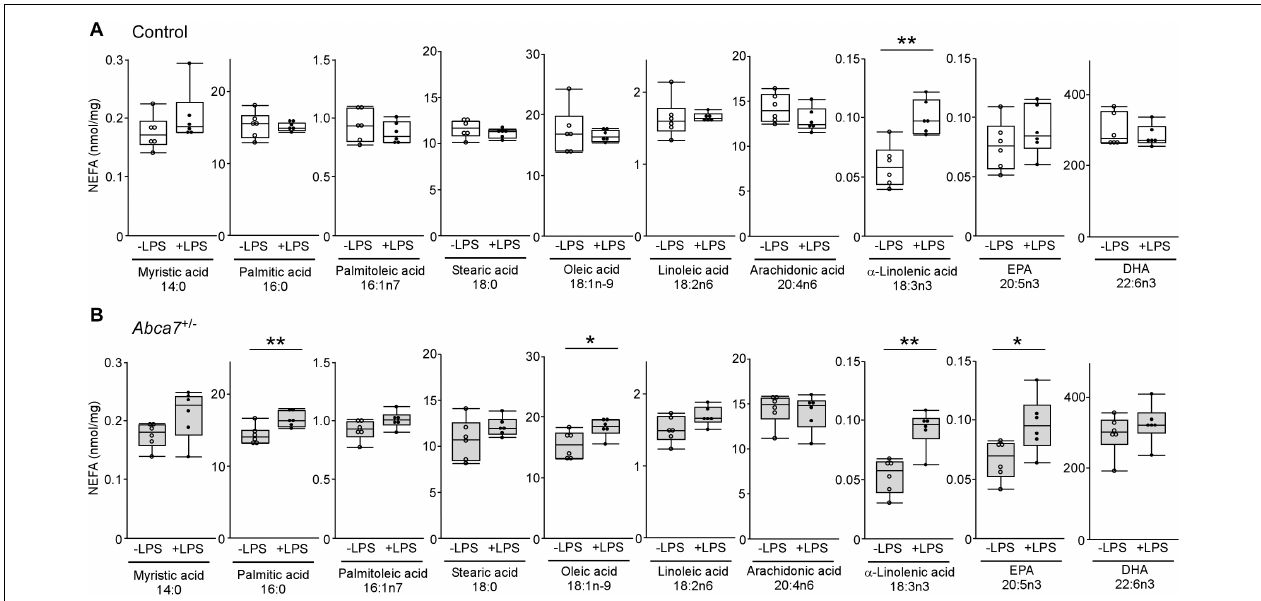
FIGURE 3 | Altered effects of LPS stimulation on brain non-esterified fatty acid levels in heterozygous ABCA7 knockout mice. The amounts of non-esterified fatty acids (NEFAs) were analyzed through mass spectrometry in the cortex of control ( A ; white) and Abca7 ± ( B ; gray) mice administrated with or without LPS. Concentration of myristic acid, palmitic acid, palmitoleic acid, stearic acid, oleic acid, linoleic acid, arachidonic acid, α -linolenic acid, eicosapentaenoic acid (EPA), and docosahexaenoic acid (DHA) were plotted. All NEFA concentrations were normalized to the protein levels. Horizontal lines, boxes, and whiskers correspond to median, interquartile range (IQR), and the furthest points within 1.5 × IQR from the box, respectively ( N = 6/each). * p < 0.05, ** p < 0.01, by student- t test.